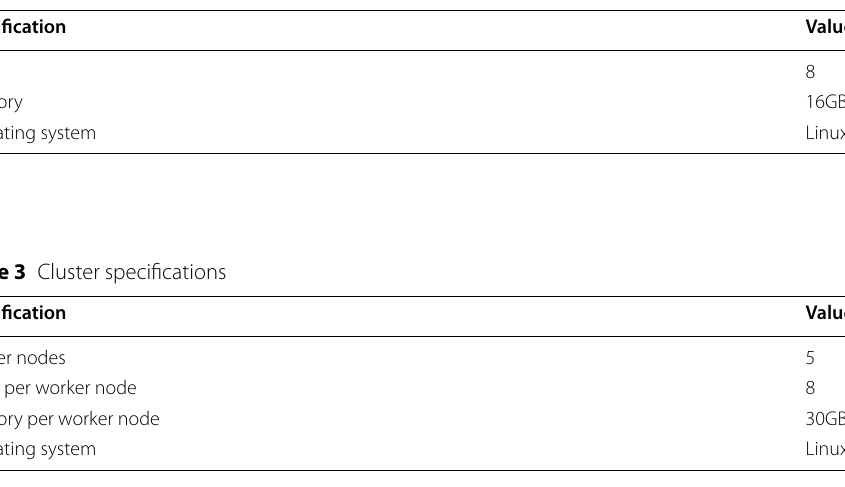
Table 2 Sequential machine specifications